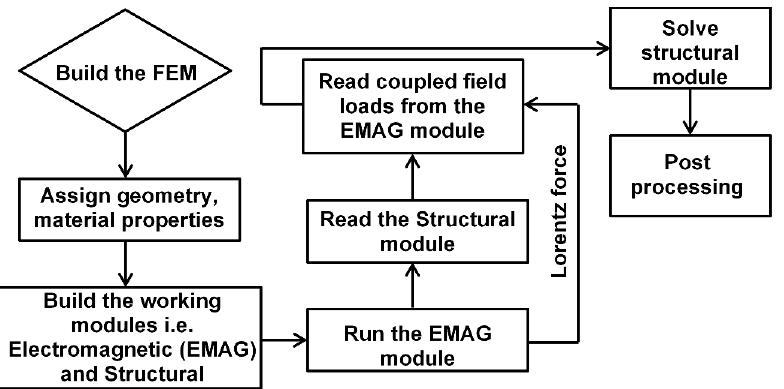
Figure 2. Simulation flowchart for the developed FEM. Table 2. Process parameters employed in this work.